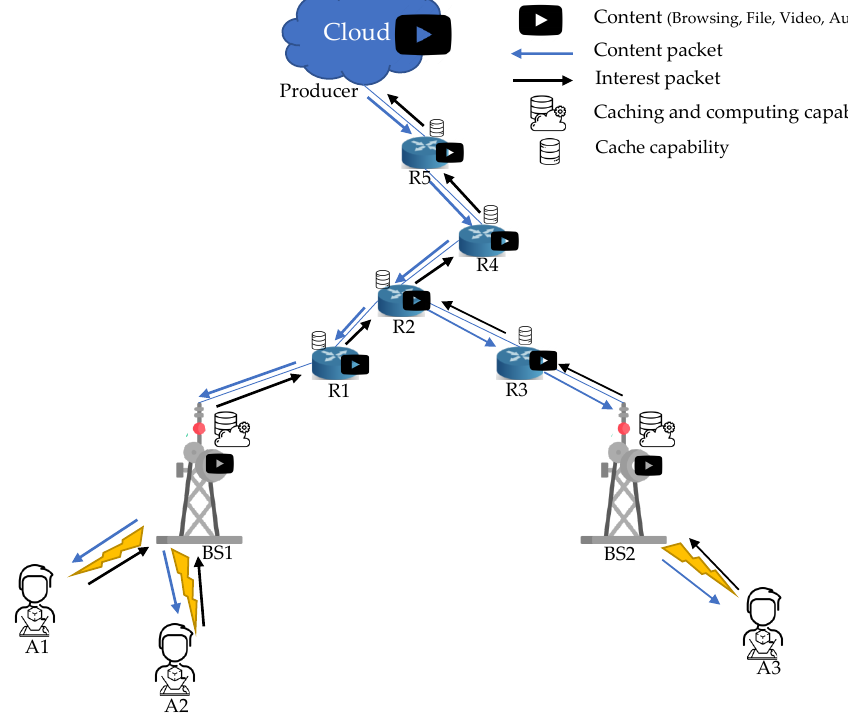
Figure 1. Overview of the basic ICN architecture for haptic-driven AR/VR